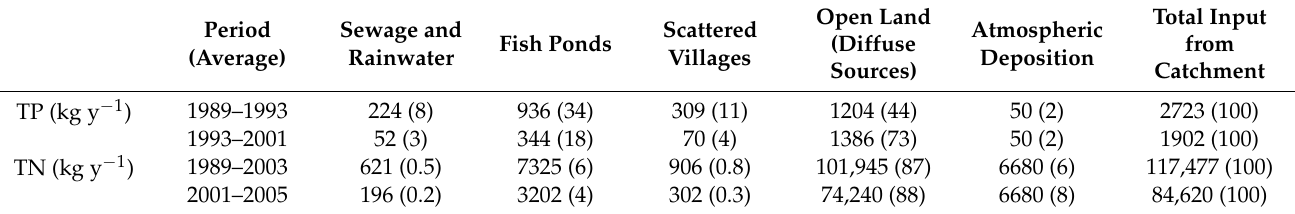
Figure 1. Map showing the study site Kilen, major fluvial inlets, modern sluice (the Kilerkanal), and coring location (yellow dot). ( a ) shows the location of Kilen in relation to northwest Jutland and the Limfjord. ( b ) shows simplified bathymetry of the lake and catchment characteristics. Table 1. External loading from the different catchment sources to Lake Kilen during two periods with extensive data (1989–1993 and 1993–2001). Numbers in brackets represent the percentage contribution, with rounding (hence the sum may not always equal 100%) (modified from